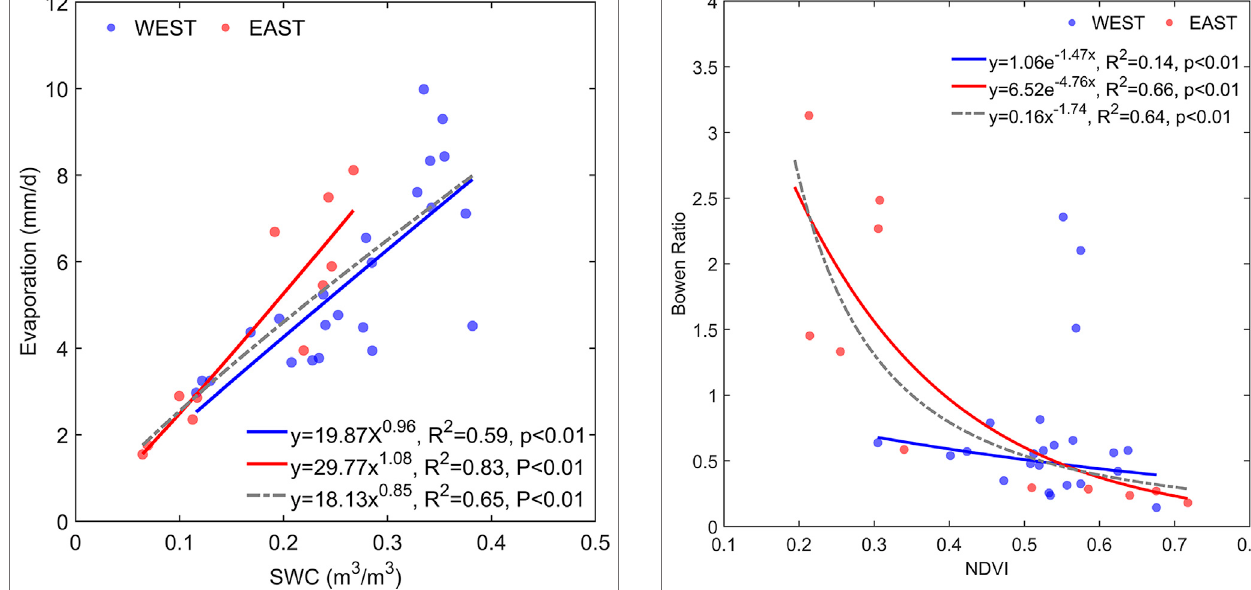
FIGURE 8 | Relationship between soil water content and evapotranspiration.